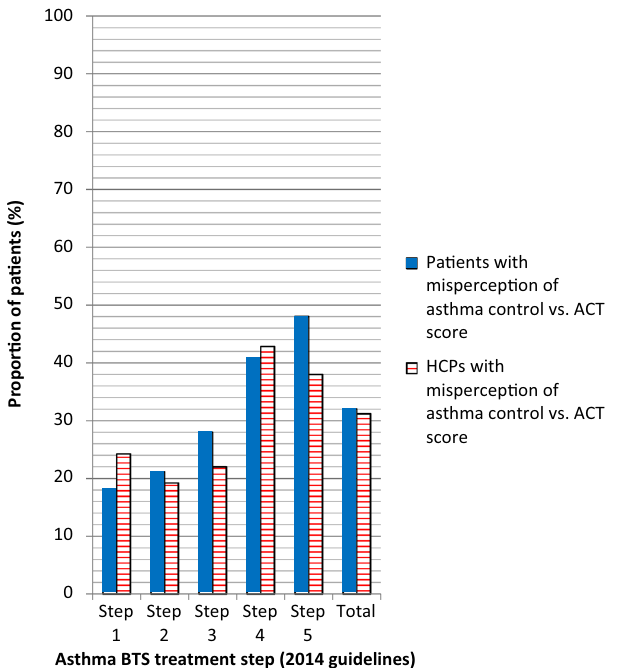
Fig. 3 Perception of asthma control did not correlate with the ACT score: patients vs. HCPs. ACT asthma control test, BTS/SIGN British Thoracic Society/Scottish Intercollegiate Guidelines Network, HCP healthcare professional. Percentages are based on the number of patients in the full analysis set. BTS step 1 = Mild intermittent asthma, step 2 = Regular preventer therapy, step 3 = Initial add-on therapy, step 4 = Persistent poor control, step 5 = continuous or frequent use of oral steroids (2014 guidelines)